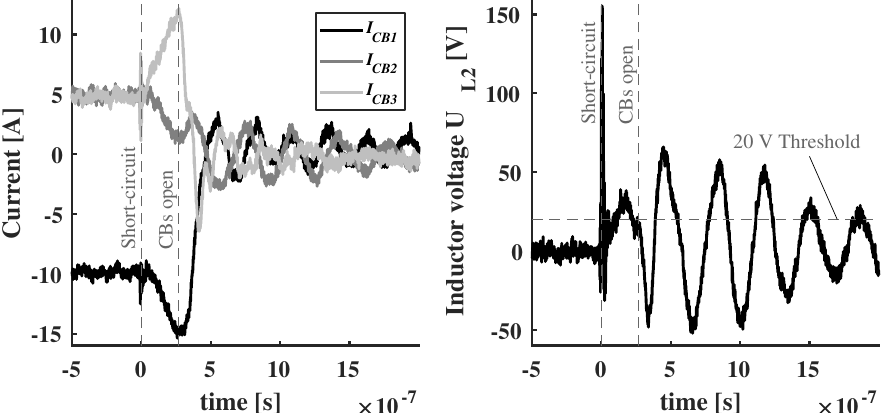
Figure 11. Experimental results for the system shown in Figure 10, showing that fault propagation can cause unnecessary tripping in low inductive systems.